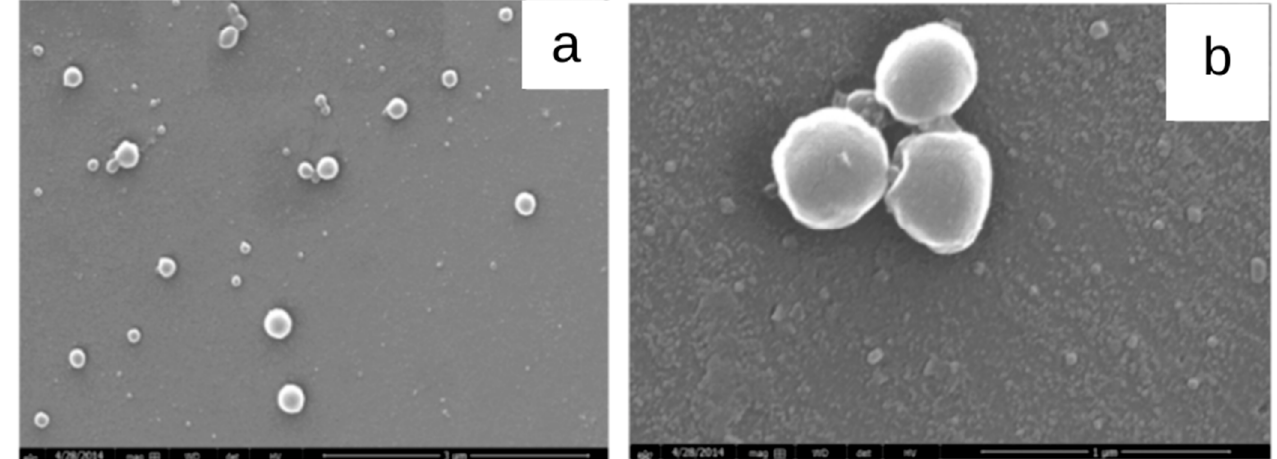
Figure 6. SEM images of acetylated cashew gum (ACG) nanoparticles ( a ) without and ( b ) with diclofenac diethylamine (DDA) (adapted from Dias et al. (2016) [74] , Copyright© 2009, Elsevier Ltd).